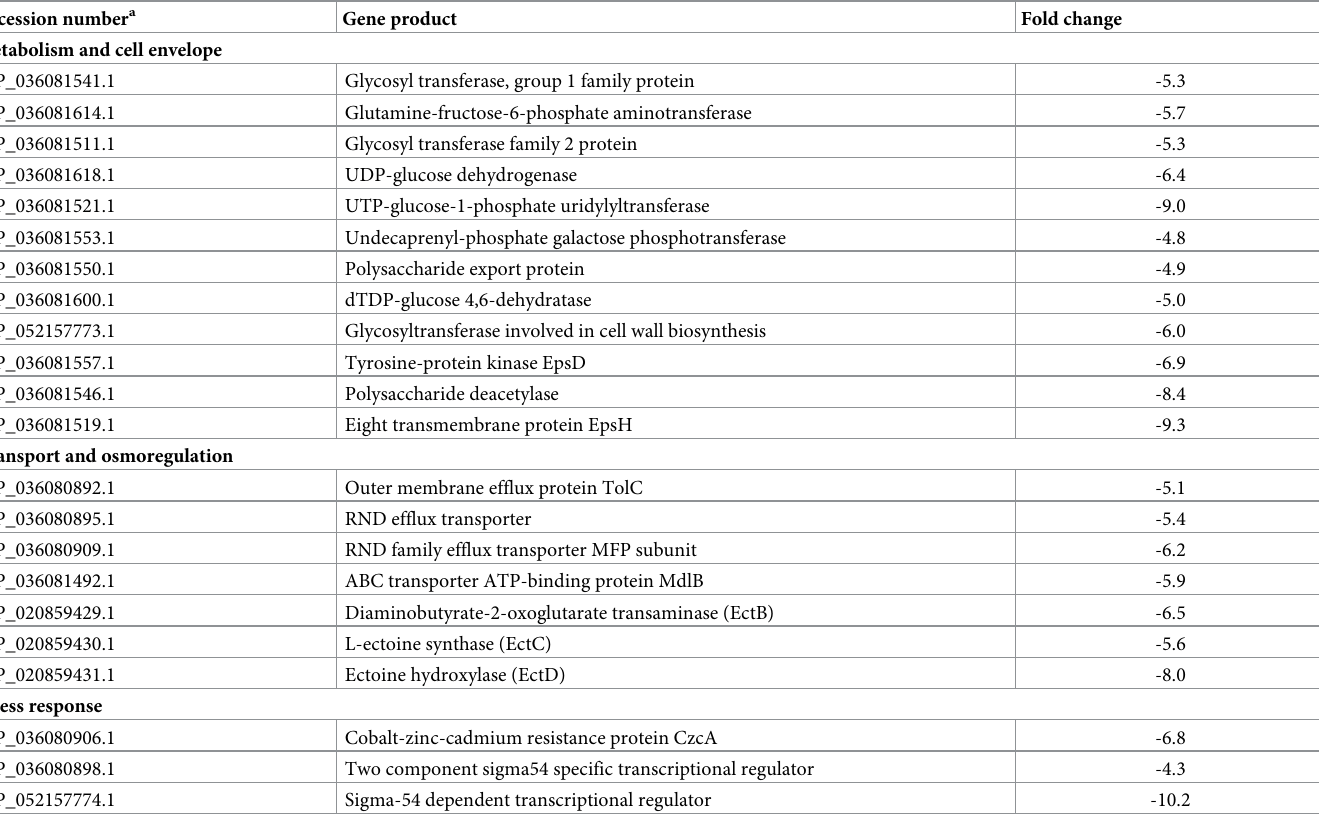
Table 3. Down-regulated genes in L . ferriphilum DSM 14647 adapted to 180 mM NaCl in relation to non-adapted non-exposed control